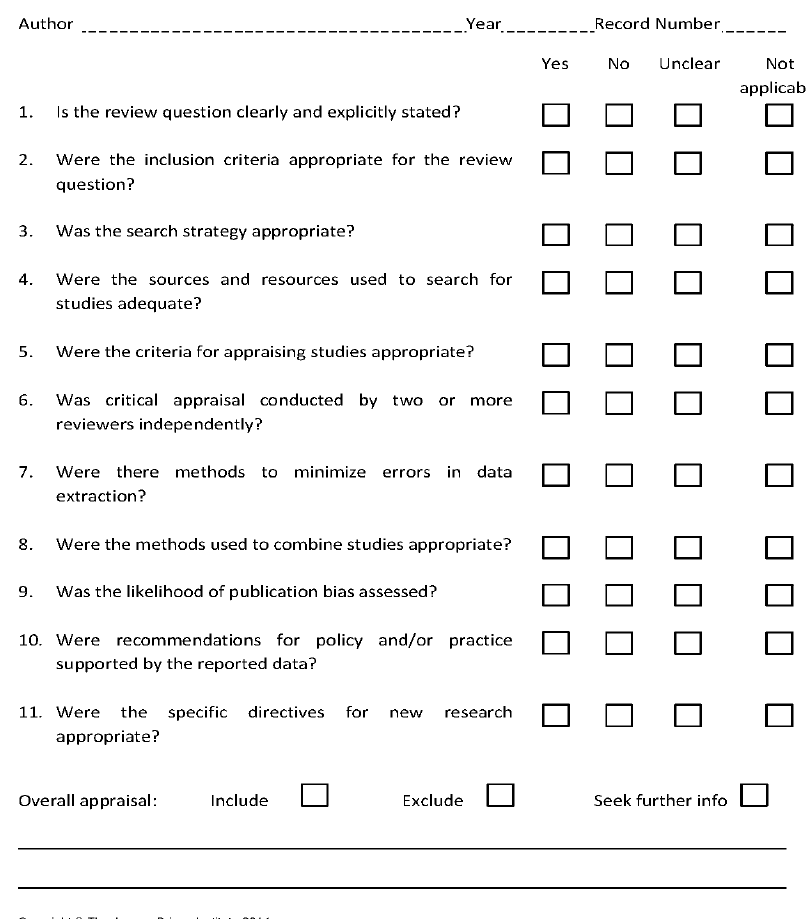
Figure A4. JBI Critical Appraisal Checklist for Systematic Reviews and Research